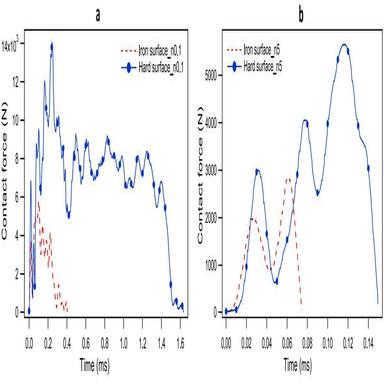
Contact force-time (F-t) graphs for iron and hard impacted surfaces for a) n0.1, b) n5.